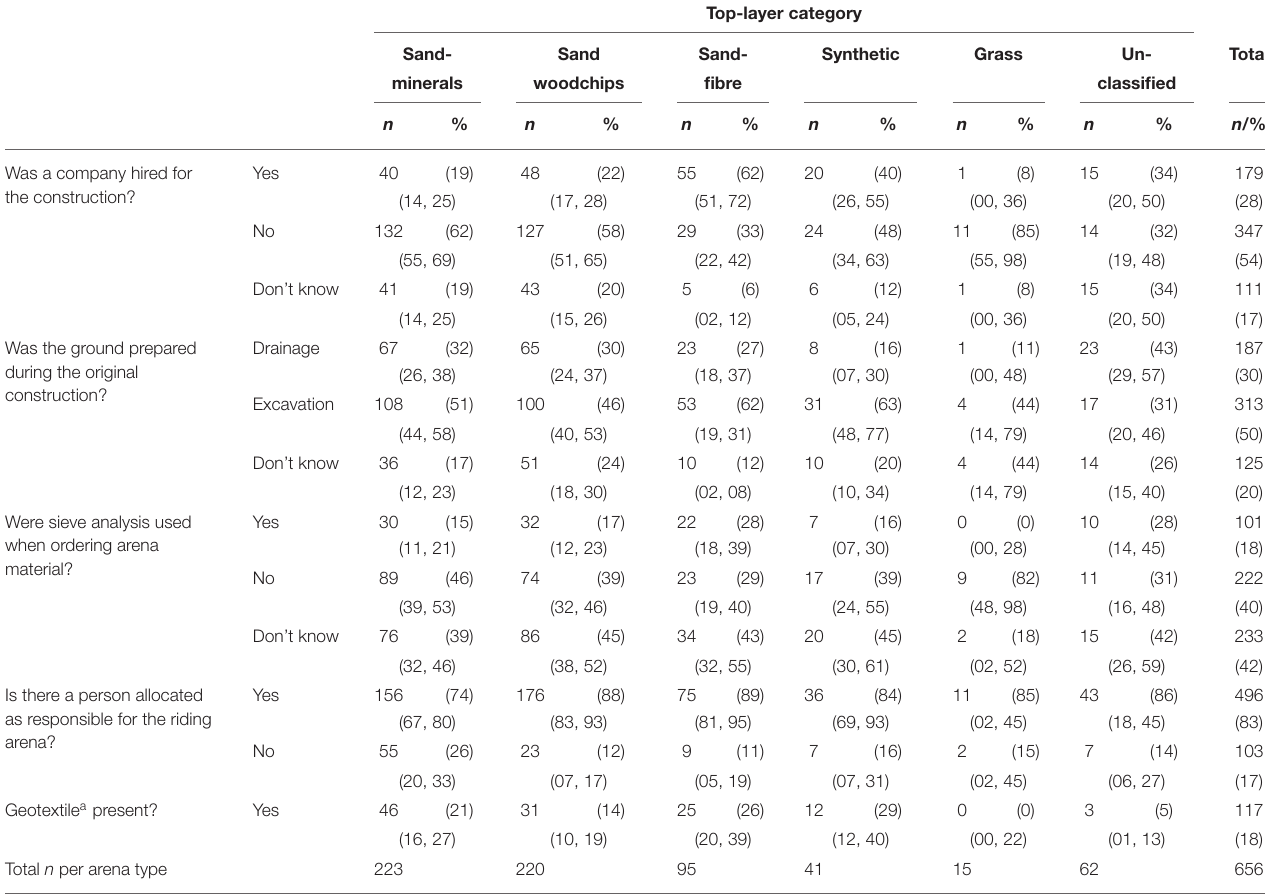
TABLE 2 | Construction of